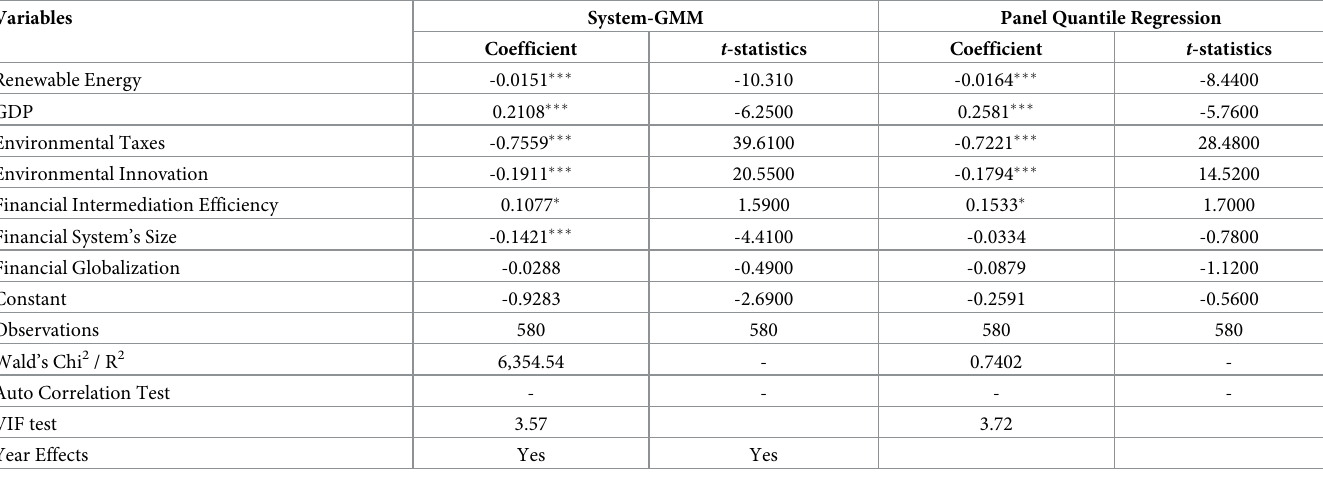
Table 5. Panel system-GMM and quantile regression analyses.